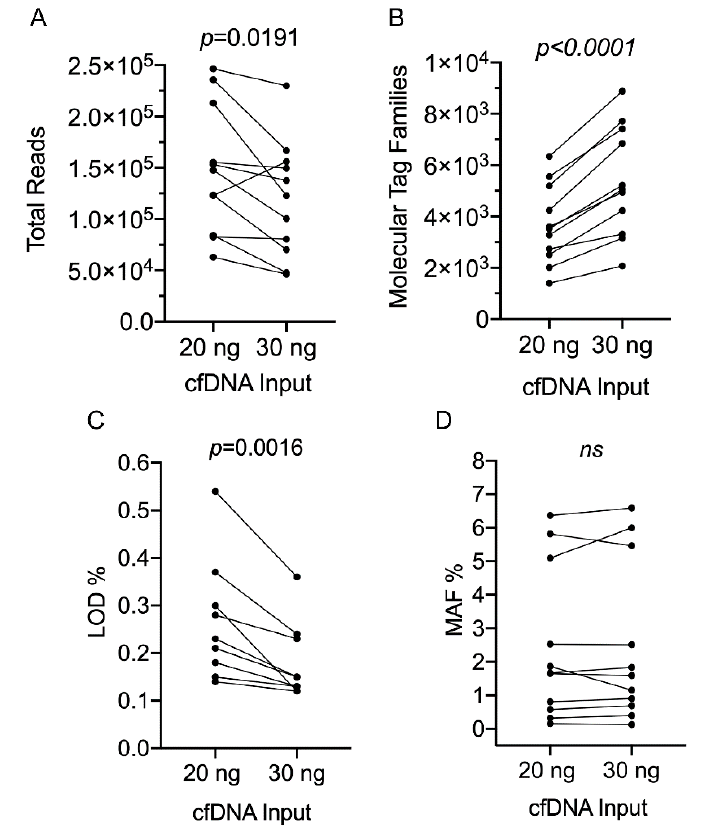
Figure 3. Relationship between sequencing performance, variant detection and cfDNA template